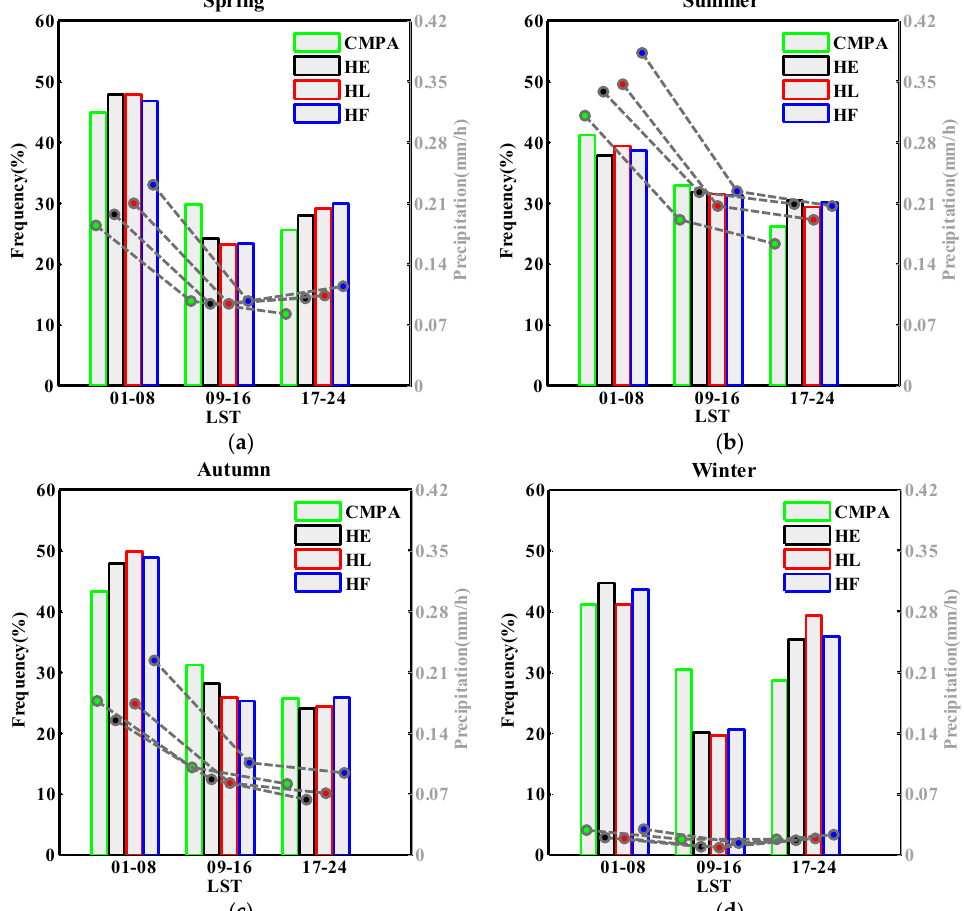
Figure 8. The precipitation intensity and frequency averaged for each season within different time ranges of a day, as derived from the CMPA data and three IMERG hourly products during 2016 to 2018: ( a – d ) represents spring, summer, autumn, and winter precipitation, respectively; all subgraphs have dual Y-axis: the left Y-axis represents the frequency (bars) of precipitation events, and the right Y-axis represents the mean precipitation intensity (dotted lines).